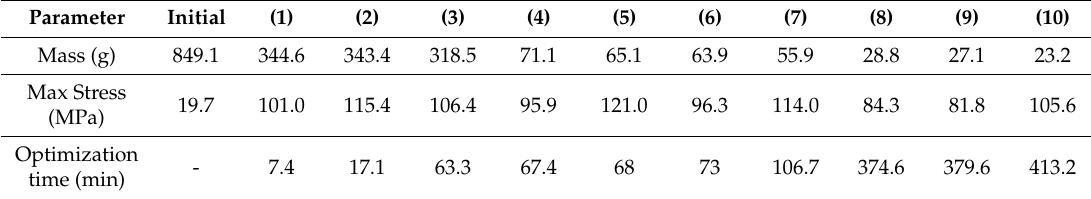
Table 5. The results of all design processes of the L-Bracket optimization.